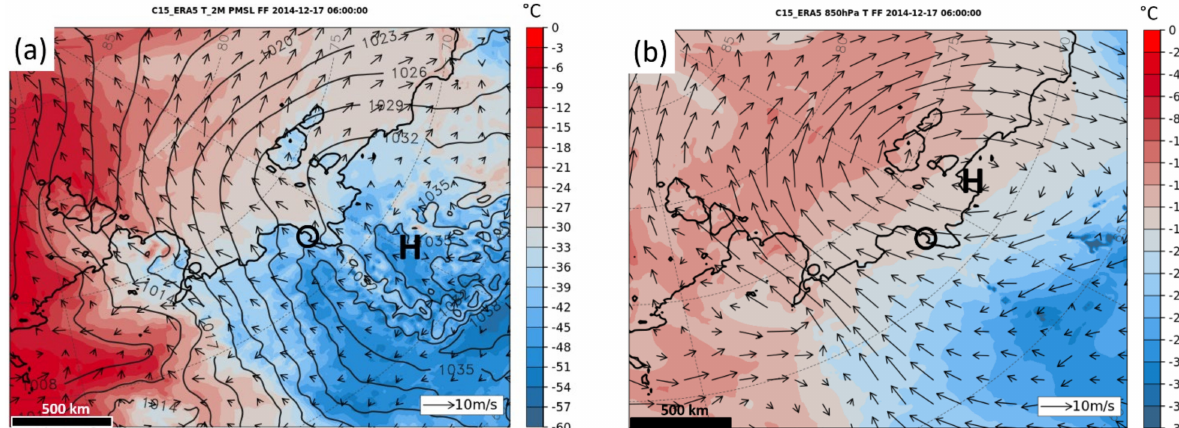
Figure 9. COSMO-CLM (CCLM) simulations with 15 km resolution for 17 December 2014, 0600 UTC: ( a ) mean sea-level pressure, 2 m-temperature and 10 m-wind vectors (scale in the lower right corner); ( b ) temperature and wind vectors at 850 hPa. The position of Tiksi is marked by an open circle, vectors are shown every 8th grid point. The vertical profiles on 17 December show the LLJ evolution in detail (Figure 10).